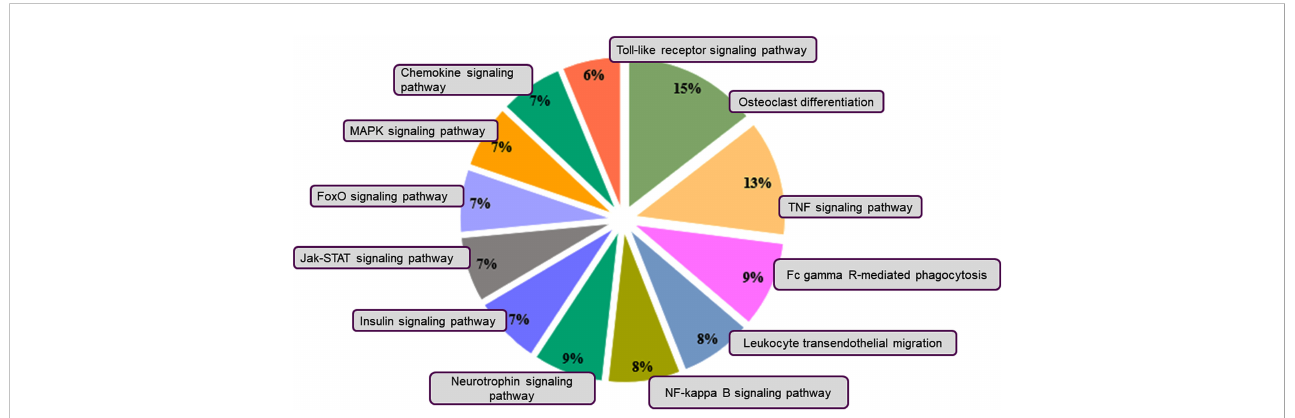
FIGURE 5 KEGG pathway classi fi cation of the downregulated genes. Pie charts depict the distribution of the KEGG pathways for the downregulated genes. The pathways were obtained by using DAVID. Different colors represent different pathways, and the percentage numbers represent the fold enrichment of the genes associated with that pathway.